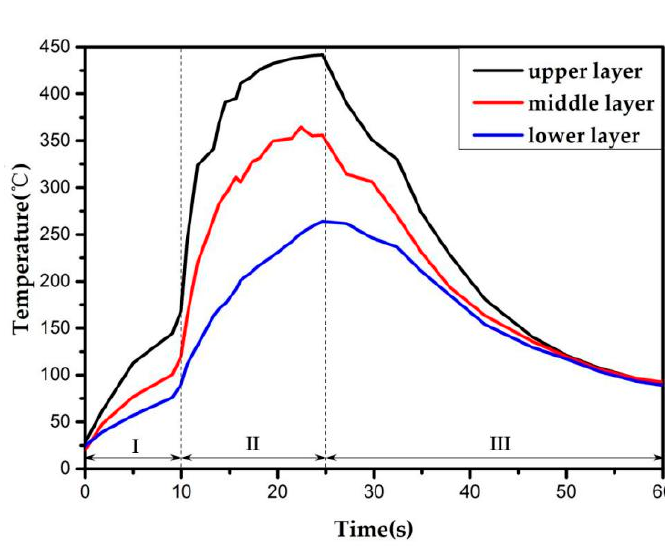
Figure 12. Temperature profile during FPW.